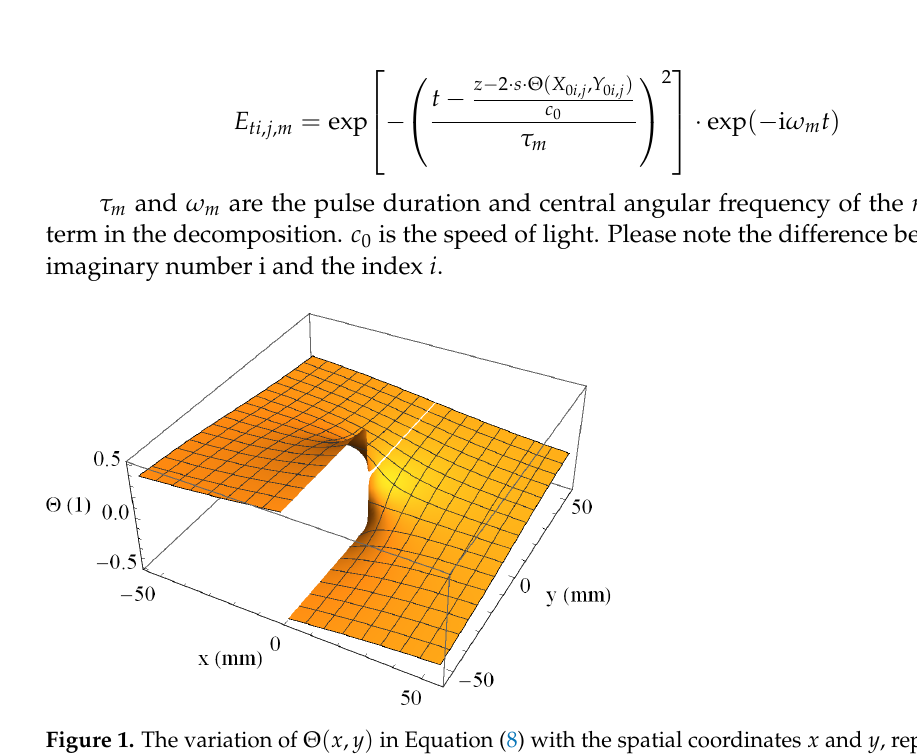
Figure 1. The variation of Θ ( x , y ) in Equation (8) with the spatial coordinates x and y , represents the topology of the helical